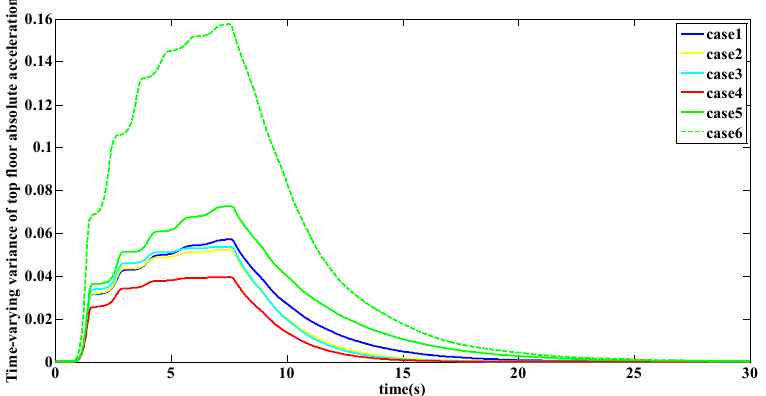
Figure 7. Time-varying variance of top displacement.